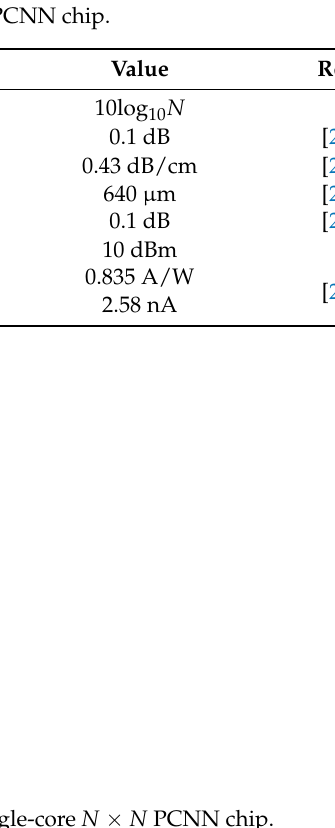
Table 3. Classification accuracies of different sizes of single-core and multicore PCNNs on the MNIST and Fashion-MNIST test sets.